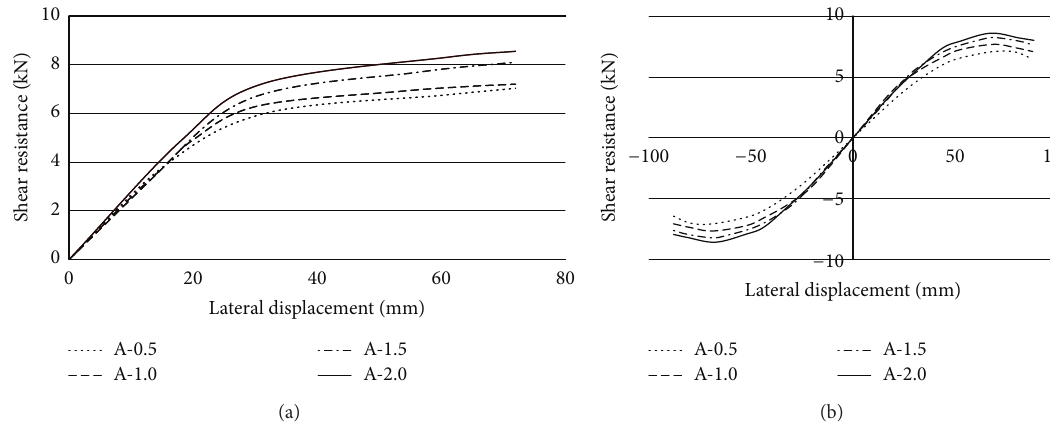
Figure 3: Curves of specimens A. (a) Monotonic curves. (b) Hysteretic envelope curve.